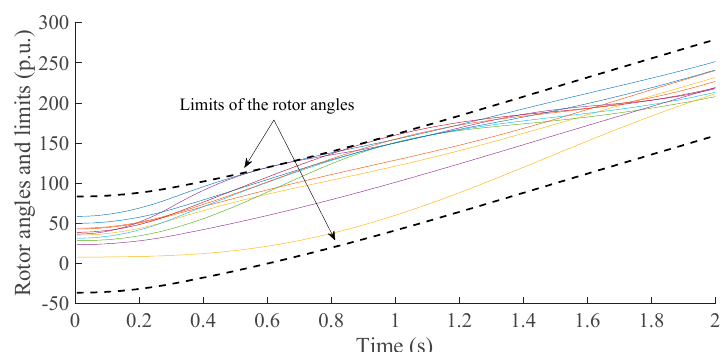
Figure 3. Synchronous generator rotor angles as provided by the solution of the TSCOPF when a short circuit is applied at bus 16.